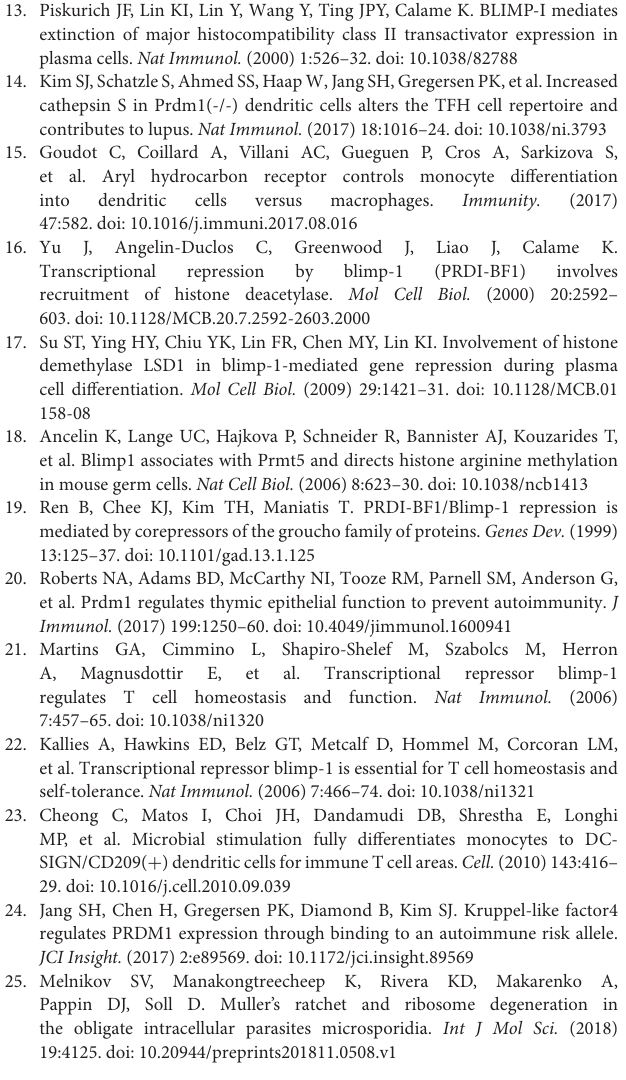
Figure S4 | Assessment of PRDM1 binding to IL6 promoter regions by ChIP-qPCR. To test PRDM1 binding to IL6 promoter, ChIP was performed. Nuclear fraction of MO-DCs and ChIP was performed by anti-RPDM1 or control IgG as described in material and method. PCR (A) or qPCR (B) was performed to assess binding of PRDM1 by primers described in material methods. #1–#8 indicates each region including putative PRDM1 binding sites in IL6 promoter. (A) is a representative image of three independent experiments. (B) To quantify the binding of PRDM1 to #5 region, qPCR was performed and calculated by the percent of input. Each dot represents an individual sample and the bar represents the mean ± SEM ( n = 3). Significance determined by Mann Whitney test. Figure S5 | Expression of IL6 by NonO or PRDM1 in myeloma cells. (A) NonO expression was knock down by transfection of anti-NonO siRNA or scrambled control siRNA. After transfection, relative level of NonO was measured by qRT-PCR and normalized to the level of housekeeping gene, POLR2A . (B) To